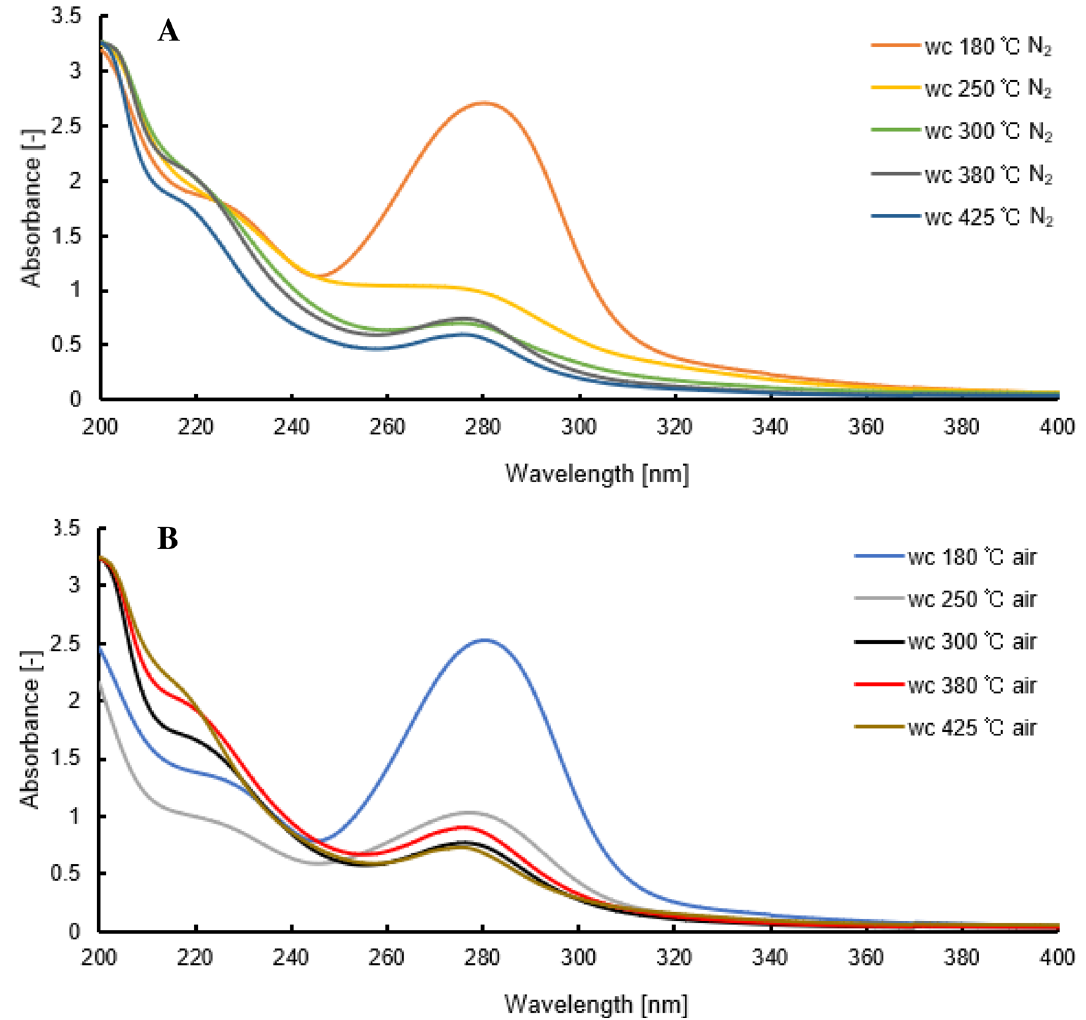
Fig. 6 UV absorbance profiles for each group of experiments (under N